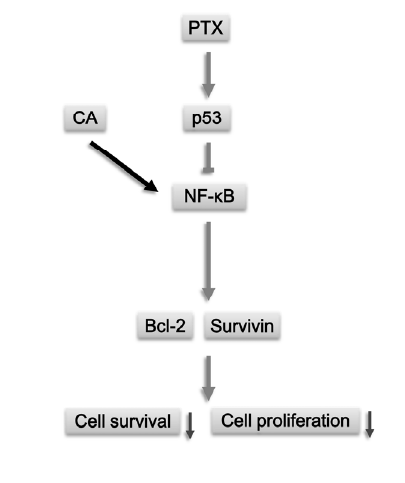
Figure 6. Proposed pathways of CA-mediated protective effect on PTX-induced proliferative inhibition in NSCLC cells. PTX is well-known for inducing the disturbance of mitosis, and PTX inhibited the proliferation of NSCLC cells in the study. Pre-treatment of CA facilitates the increased level and nuclear translocation of transcription factor NF- κ